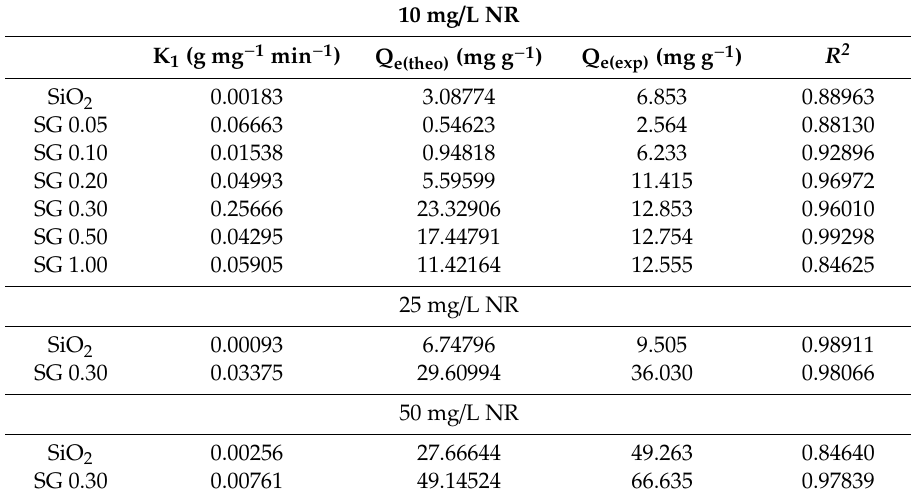
Table 1. Pseudo-first-order kinetic parameters for the adsorption of neutral red at various initial concentrations.